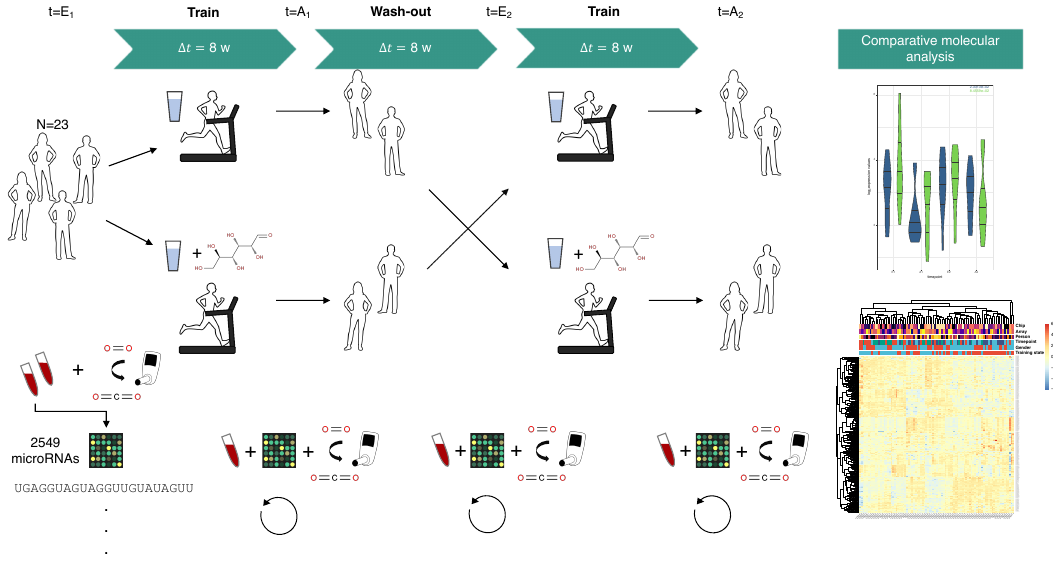
Figure 1. Overview on study design. Healthy and untrained participants were randomly assigned to any of two training groups, each performing of eight weeks of 4 × 45 min training, followed by a wash-out phase, again followed by eight weeks of endurance training. In the first period participants of one group orally administered glucose-solution 15 min before each running session, while participants of the second group administered carbohydrates in their second training period (cross-over). At four timepoints ( E 1 , A 1 , E 2 , and A 2 ) a blood-sample was taken and measured using complementary DNA (cDNA) microarrays probed with 2549 human